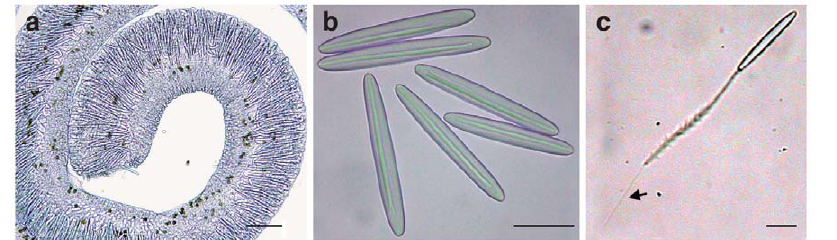
Figure 2. Preparation of cnidocysts. (a) A filament of Aiptasia diaphana containing packed cnidocysts. Bar, 100 m m. (b) Isolated cnidocysts. Bar, 25 m m. (c), A discharging cnidocyst. Following release of the folded 150- m m injector, only its smooth tip (50 m m long, submicron diameter) can penetrate the skin (see arrow). Bar, 25 m m.